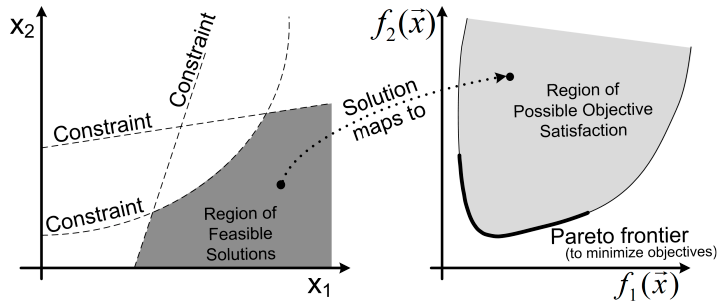
Figure 11. Representation of a multi-objective, multi-constraint optimization problem and resulting Pareto frontier.